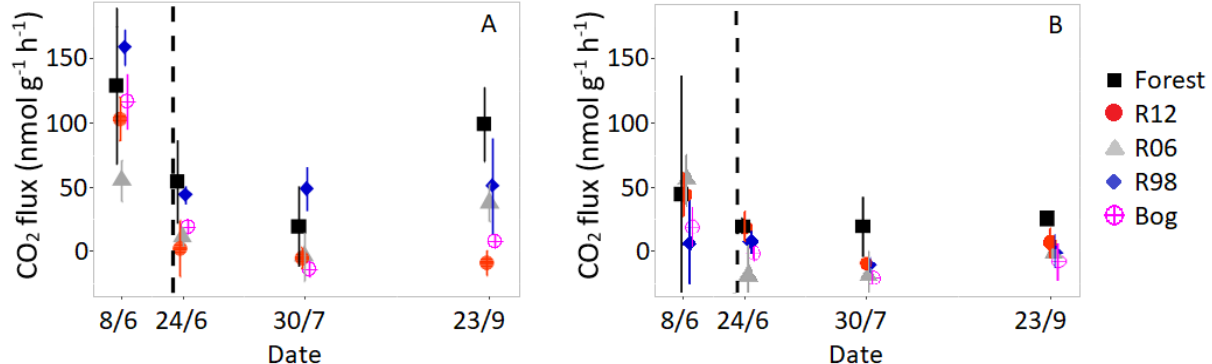
Figure 1. Carbon dioxide (CO ) fluxes for changed water table levels, per core depth over time (n=5). Error 2 bars are standard error. Dotted vertical line is timing of water table change (from low to high). A) Shallow cores, B) Deep cores.